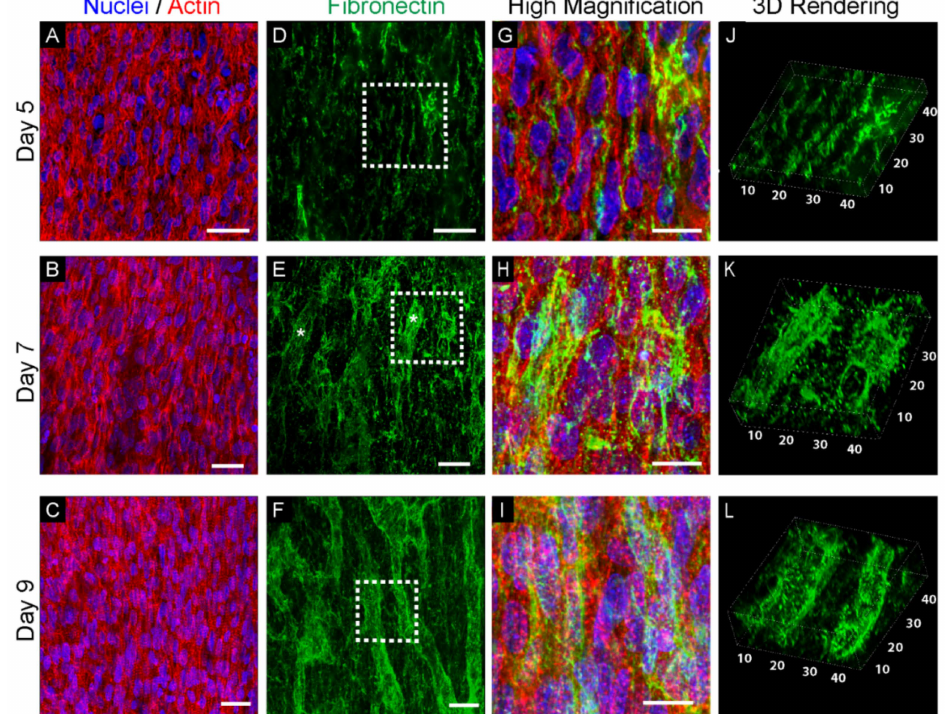
Figure 2. Imaging of the myocardium of the left ventricle at days 5, 7, and 9 of development. ( A – C ) Actin staining of the aligned cardiomyocyte cytoskeleton at days 5, 7, and 9 (red = actin, blue = nuclei). ( D – F ) Images of the fibronectin matrix (green) shows ( D ) very thin fibronectin fibers at day 5, ( E ) emergence of some larger bundles (marked by white stars) around preliminary capillary lumens at day 7, and ( F ) an interconnected network of fibronectin-positive tubes at day 9. ( G – I ) Magnified images of the areas marked by dashed white boxes in ( D – F ) show how the fibronectin matrix is organized around the cardiomyocytes. ( G ) At day 5, small fibronectin fibers are regularly located between cardiomyocytes, following the main direction of alignment. ( H , I ) At day 7 and day 9, the large bungles of fibronectin around the developing capillaries are also following the main cardiomyocyte orientation. ( J – L ) 3D rendering of the fibronectin shows: ( J ) at day 5, very small filaments with a main direction of alignment; ( K ) at day 7, the formation of much longer fibronectin structures with what appears to be poorly defined lumens; ( L ) at day 9, fibronectin highlighting what appears to be well-aligned capillaries. Scale bars are 20 µ m ( A – F ) and 10 µ m ( G – I